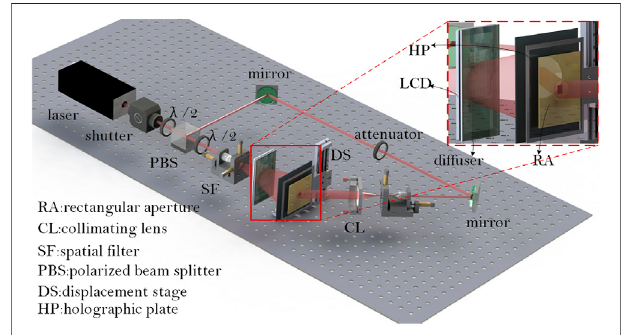
FIGURE 9 | Holographic printing optical scheme.